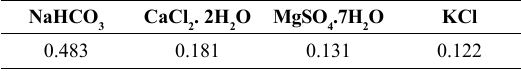
Table 2. Chemical composition of NS4 solution